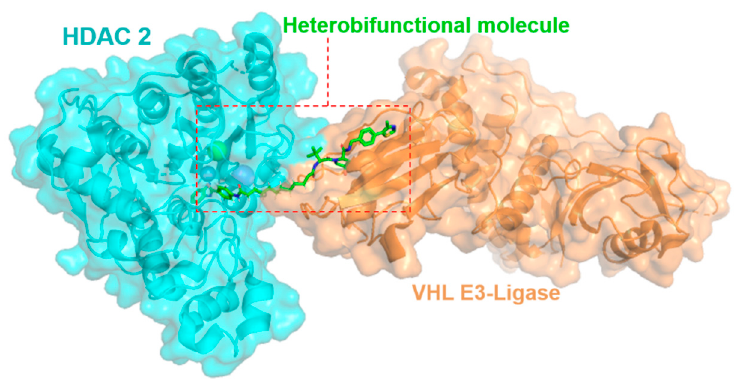
Figure 1. Model of HDAC2 and the Von Hippel-Lindau E3-ligase brought into proximity with a heterobifunctional molecule.